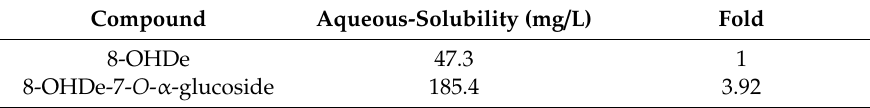
Table 1. Aqueous solubility of 8-OHDe and 8-OHDe-7- O - α -glucoside.